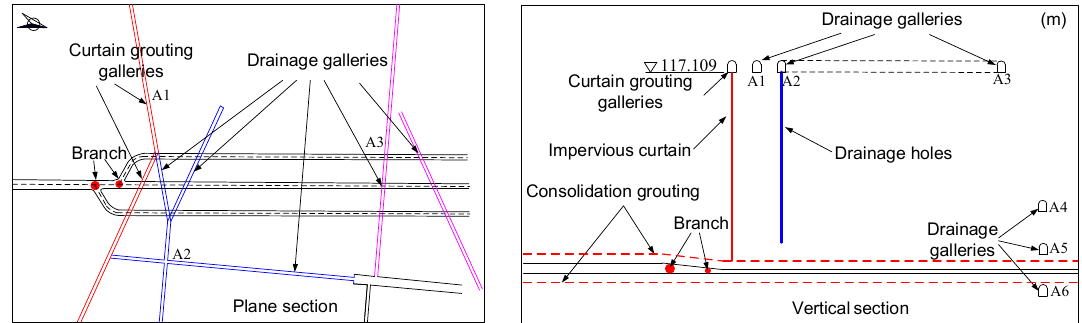
Figure 5. Illustration of seepage-control measures for the hydropower in the Yangjiang pumped storage power station.